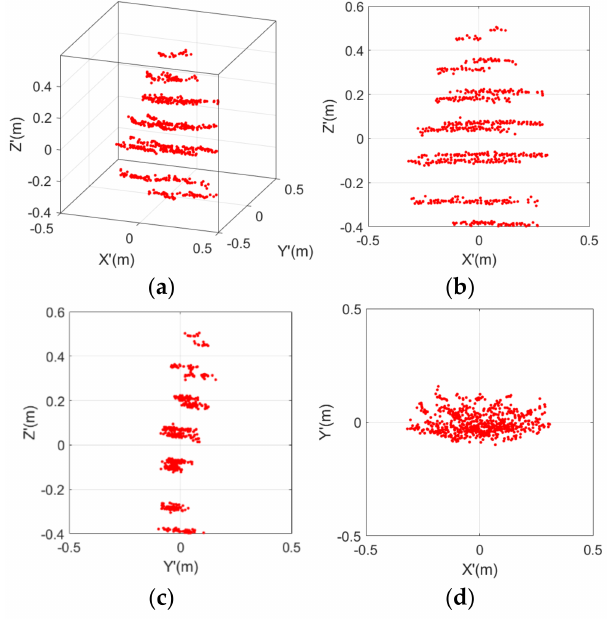
Figure 3. Example of a pedestrian candidate: ( a ) point cloud; ( b – d ): the projected images in the main plane, secondary plane and tertiary plane.